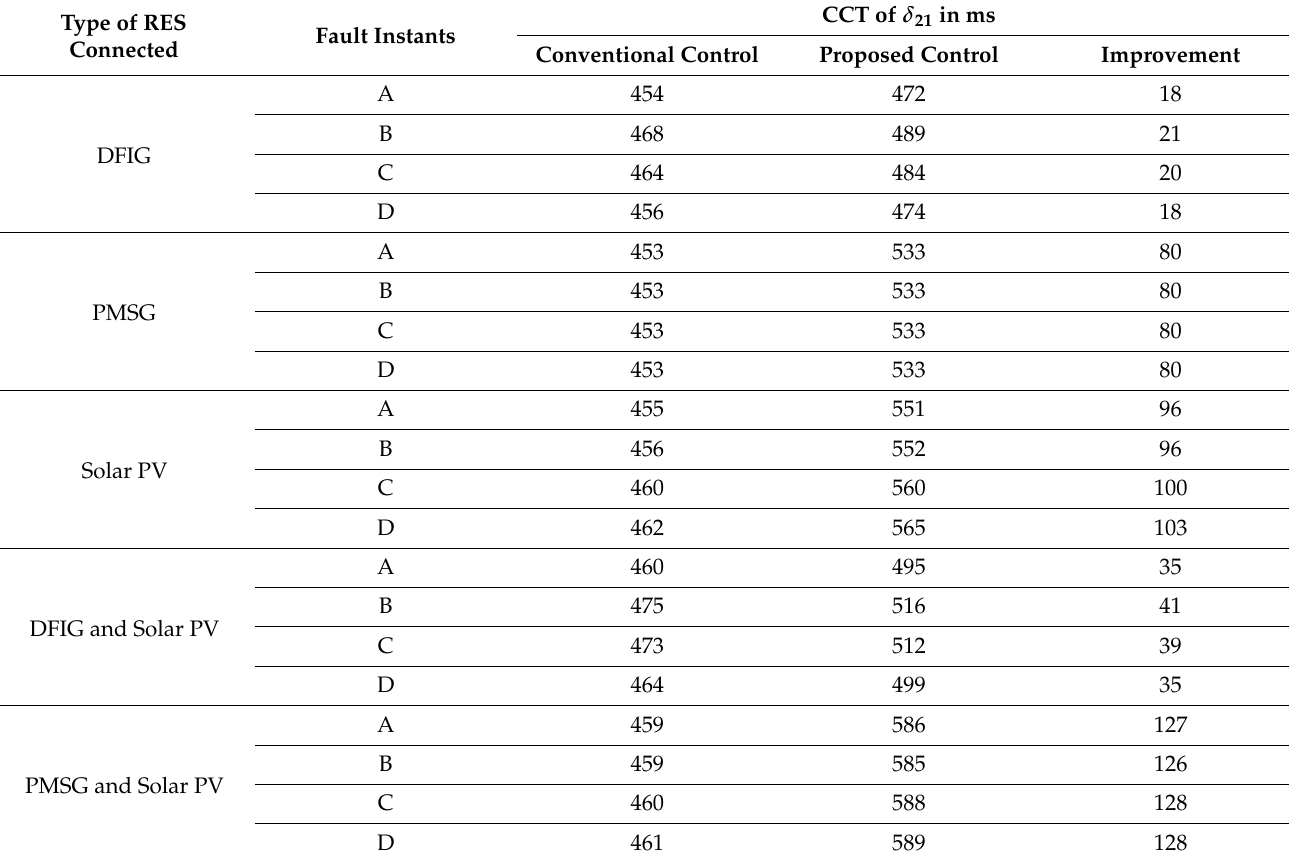
Table 2. CCT of generator-2 when connected to different RES at different fault instants.